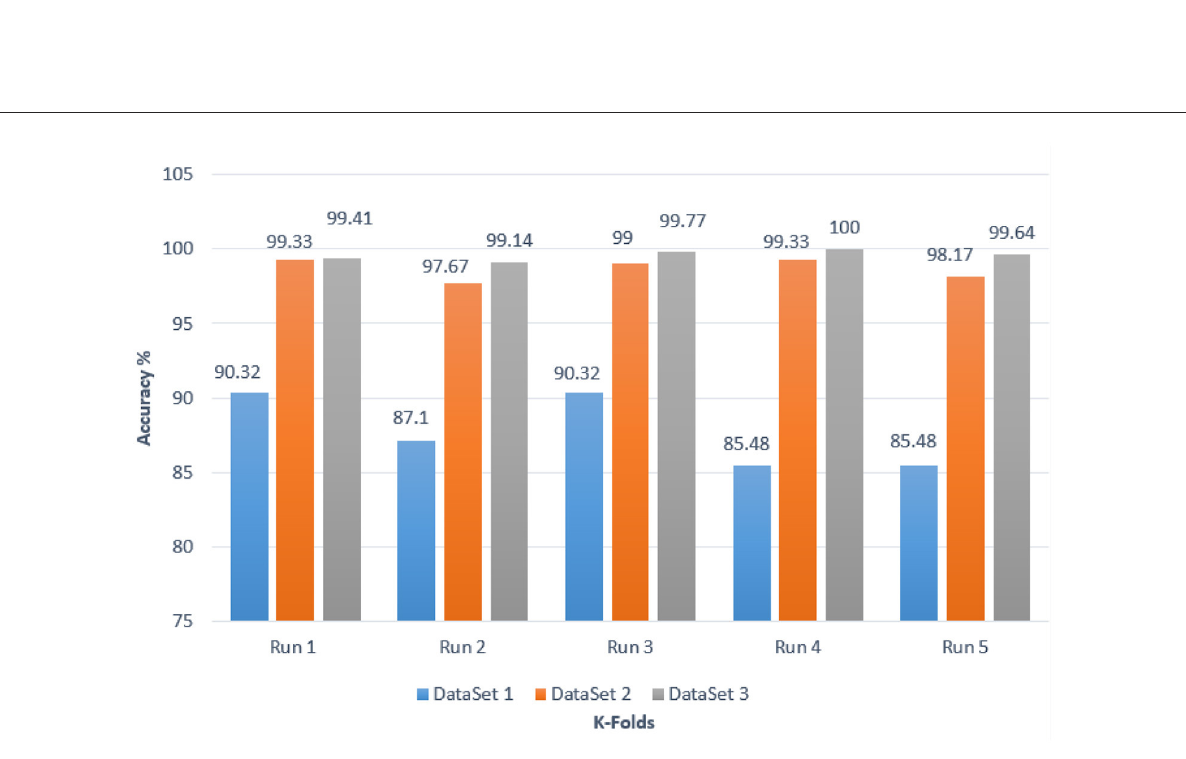
FrontiersinPublicHealth 10